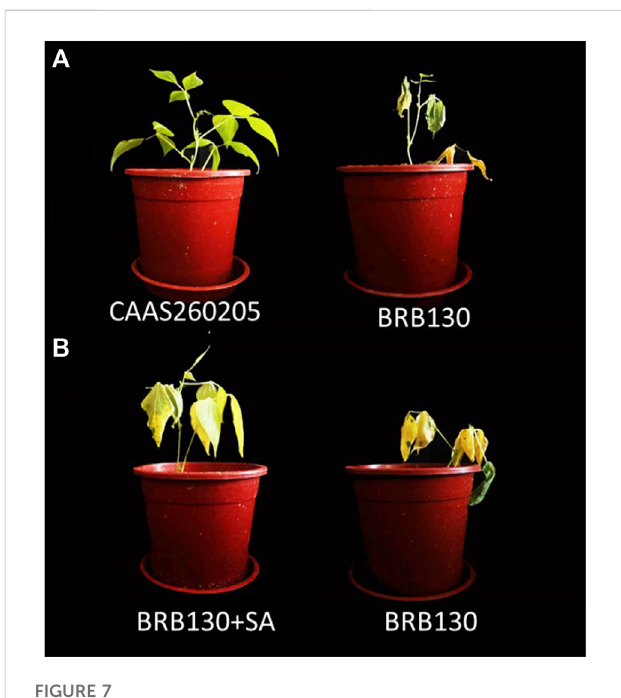
FIGURE 7 Phenotype of common bean genotype under Fop infection. (A) resistant genotype CAAS260205 and susceptible genotype BRB130 were tested with Fop isolate for 24 days., (B) susceptible genotype BRB130 (left) under fi ve consecutive days of exogenous SA treatment and BRB130 without SA application (right) as control were inoculated with Fop